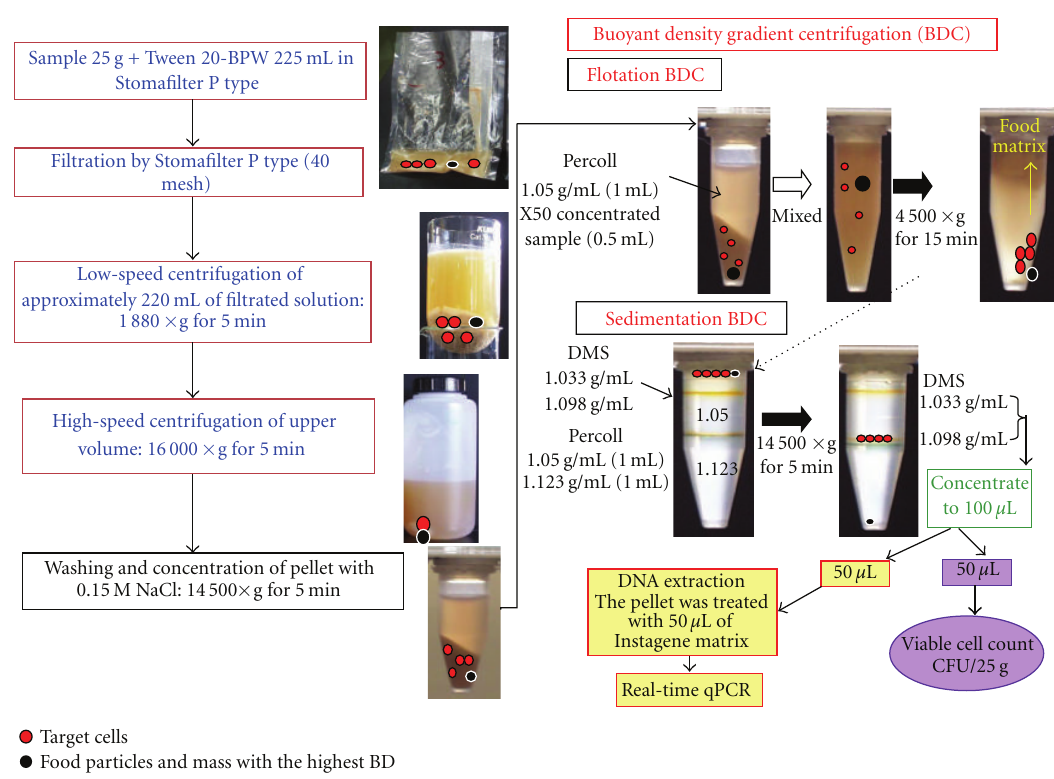
Figure 2: Optimal protocol for rapid separation and concentration of food-borne pathogens in food samples using filtration, centrifugation, and BDC prior to quantification by viable-cell counting and real-time